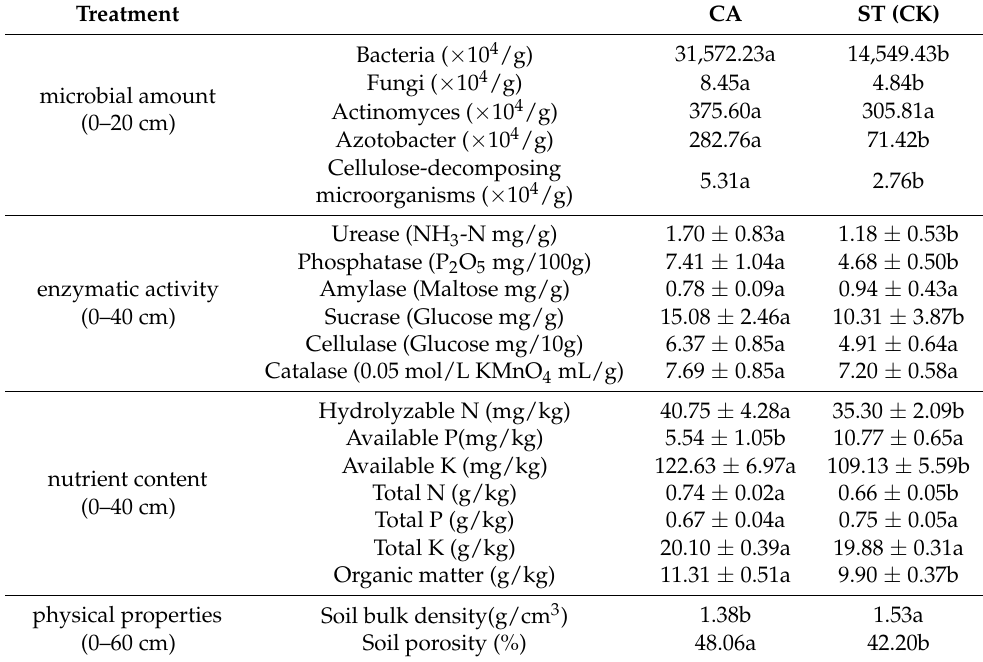
Table 2. Comparison of average microbial amount, enzymatic activity, nutrient content, soil bulk density, and porosity (average values for four seasons). The data has been modified based on the study of Xi et al.